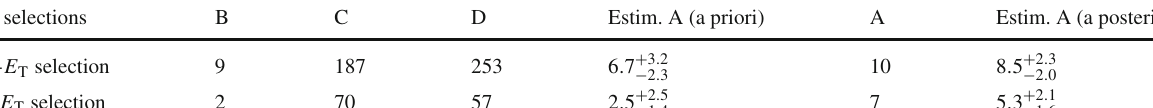
and the signal strength is fixed to zero. This corresponds to the simple